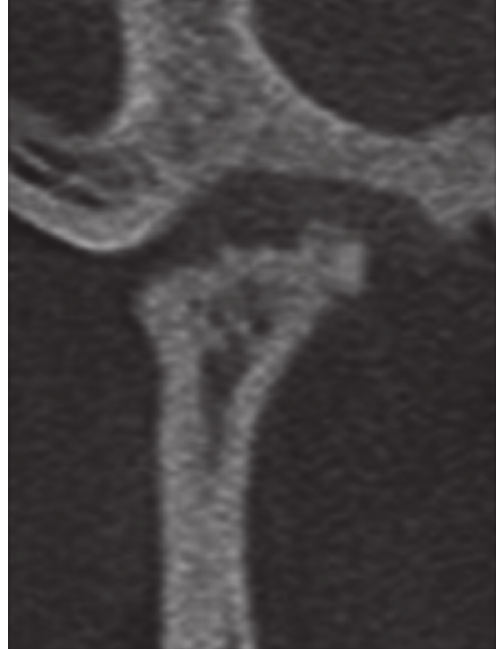
Figure 2- Cone-beam computed tomography images of temporomandibular joint (coronal view) showing advanced destruction of mandibular